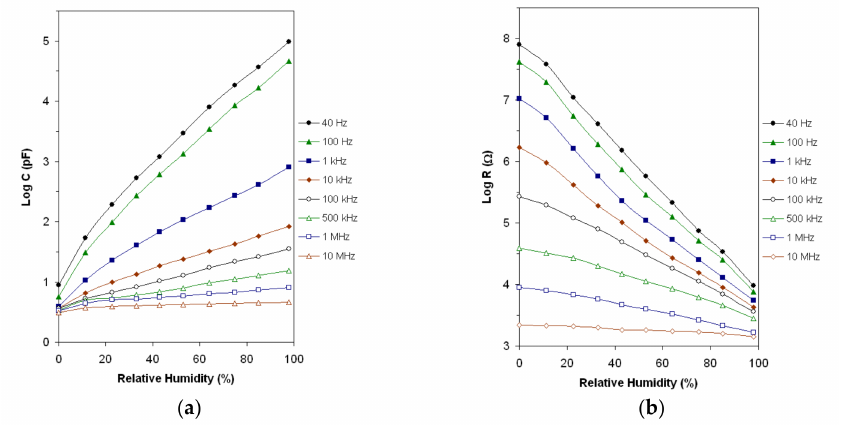
Figure 6. The capacitance ( a ) and resistance ( b ) vs. RH characteristics at eight working frequencies in 40 Hz–10 MHz frequency